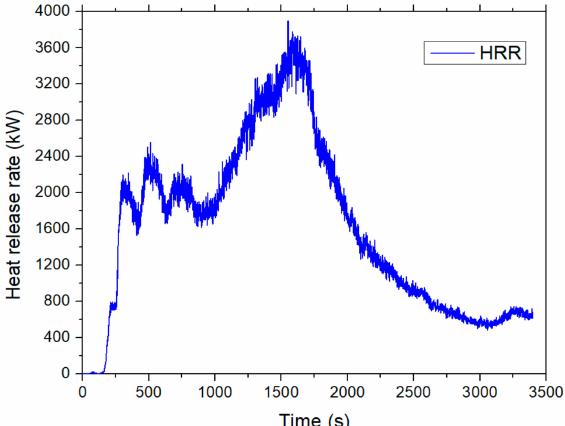
Figure 3. The heat release rate from an experimental study (one vehicle) by Park et al. (2019)